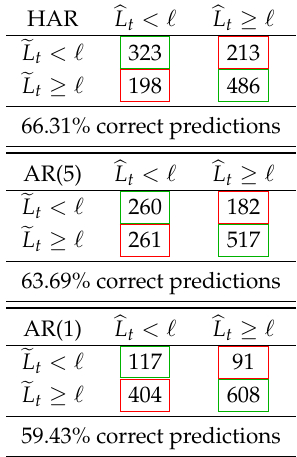
Table 7. Number of decisions for (cid:96) = − 1.28, 1220 out-of-sample observations. HAR